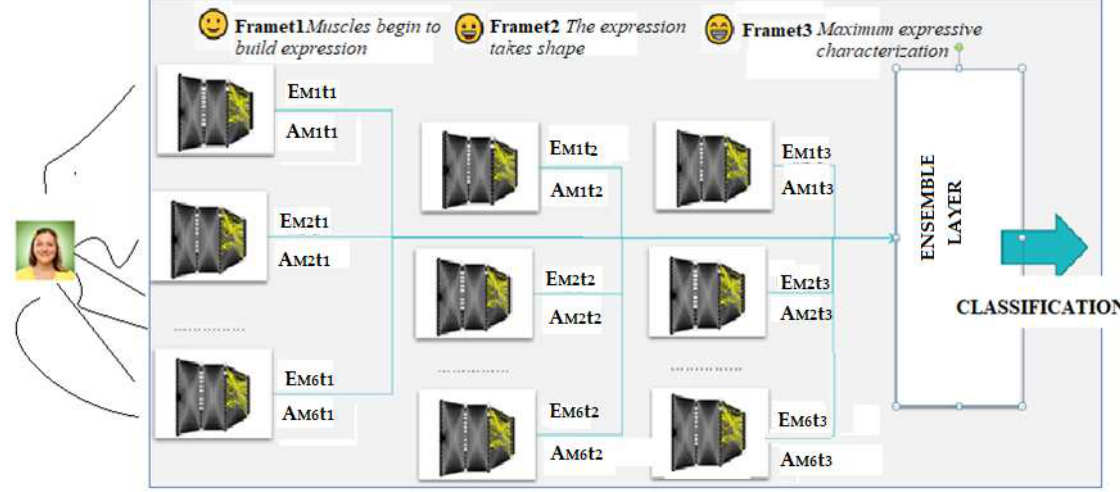
Figure 2. Network Figure 2. Network architecture.